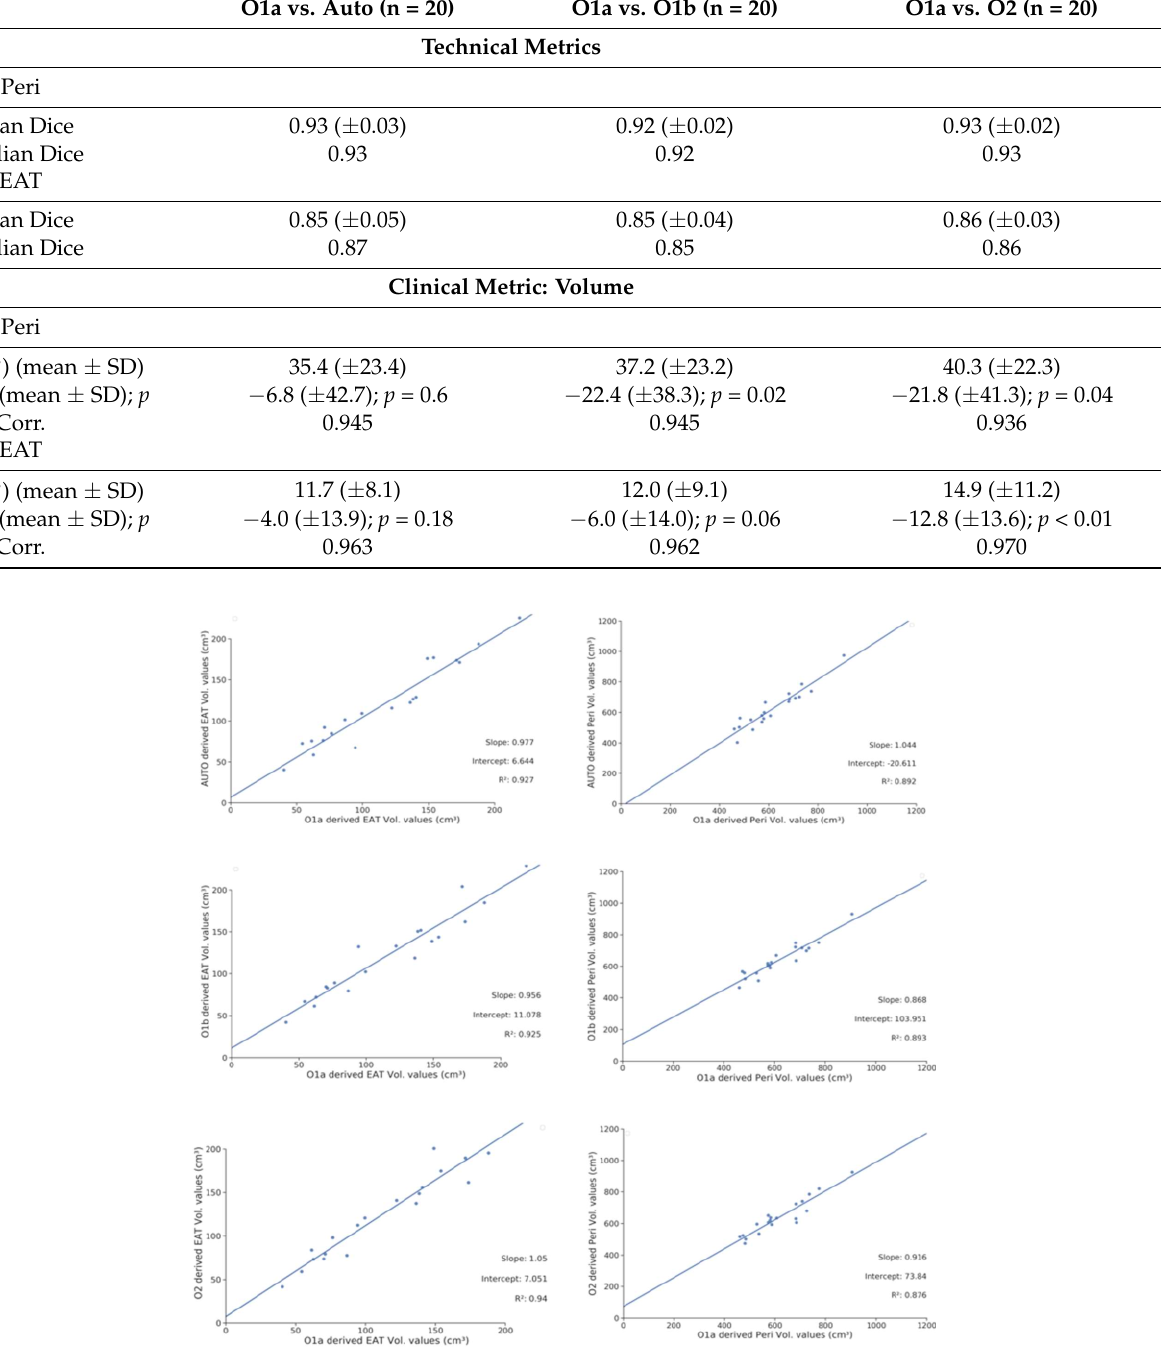
Figure 3. Correlations of EAT and Peri volume measures for the automatic and manual segmentation of the intra- and interobserver measures. Peri Vol: pericardial volume; EAT Vol: epicardial adipose tissue volume; O1a: initial segmentations made by Observer 1. O1b: second segmentations made by Observer 1; O2: Segmentation made by Observer 2. The blue line is the fitted regression